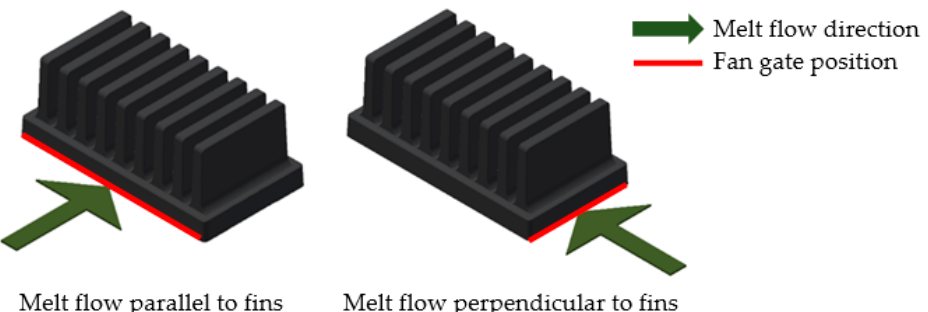
Figure 2. Melt entrance along the edge of the base (red), direction of melt flow depicted by green arrow. ( Left )—edge of longer base’s side (melt flow parallel to the fins), ( Right )—edge of shorter base’s side (melt flow perpendicular to the fins).